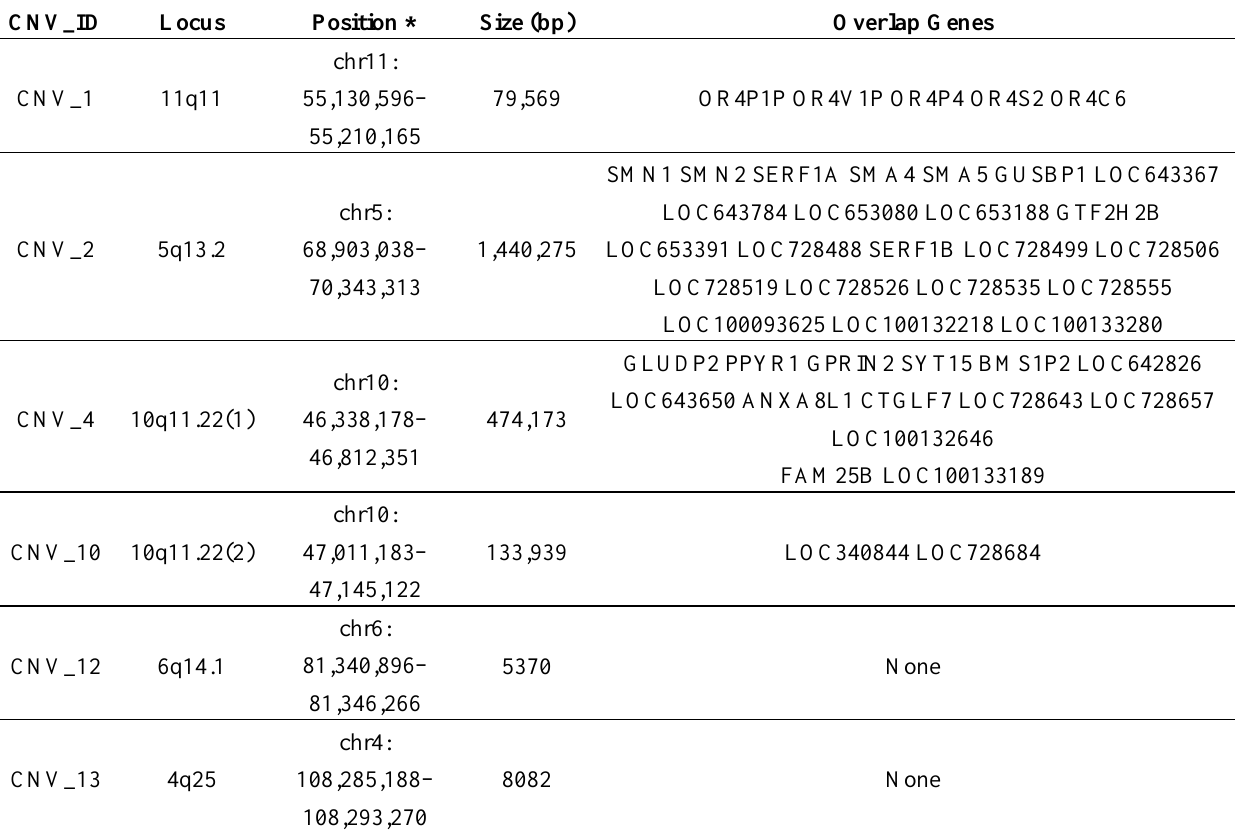
Table 1. Basic information of selected candidate CNV